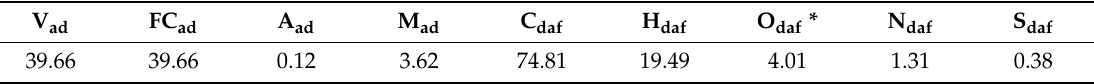
Table 1. Proximate and ultimate analyses of Huolinhe lignite